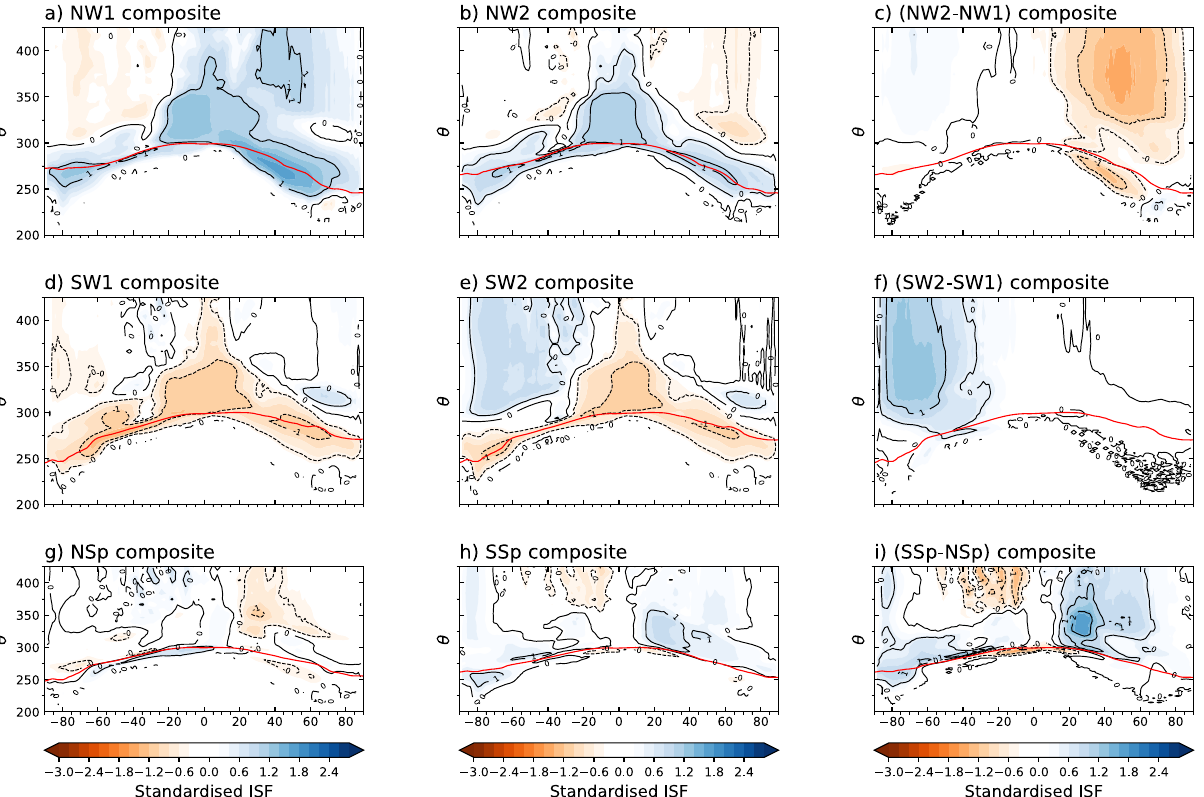
Fig. 3 Composites of the standardized isentropic stream function for each cluster. a , b , d – h Composite anomalies of the standardized stream function for six clusters from the annual mean. Red lines represent the location of the median surface potential temperature in shown clusters c , f , i The difference between clusters: ( c ) NW 1 – NW 2 , ( f ) S W 1 – SW 2 , ( i ) SSp – NSp . Colors as in Fig. 1. Red lines in ( c , f , i ) are shown for clusters NW 1 , SW 1 , NSp ,